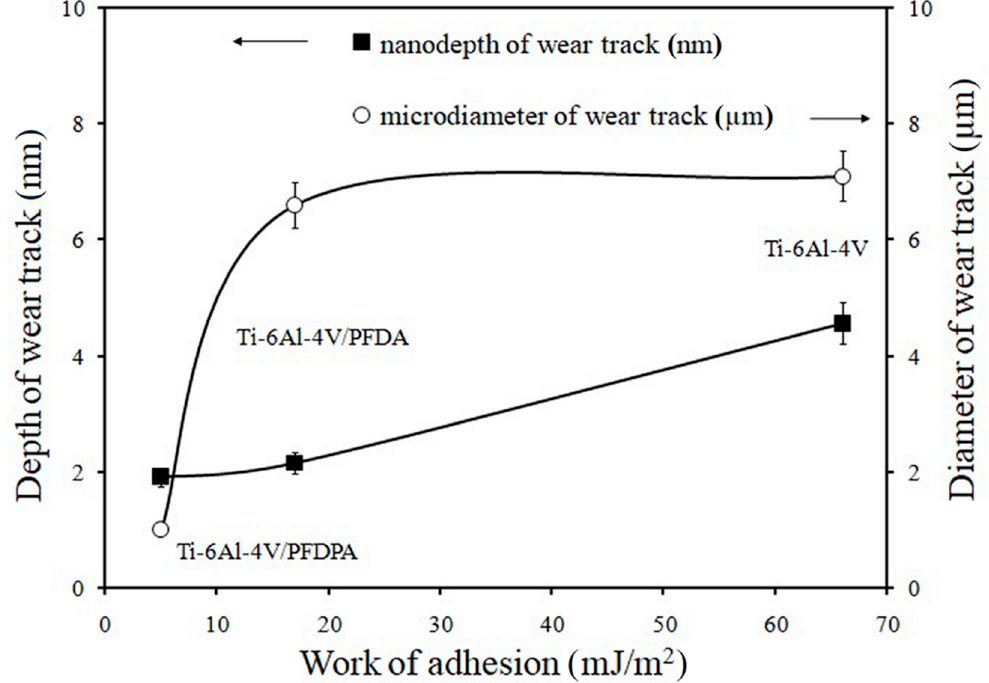
Figure 9. The relationship between the depth / diameter of the wear track and the work of adhesion.